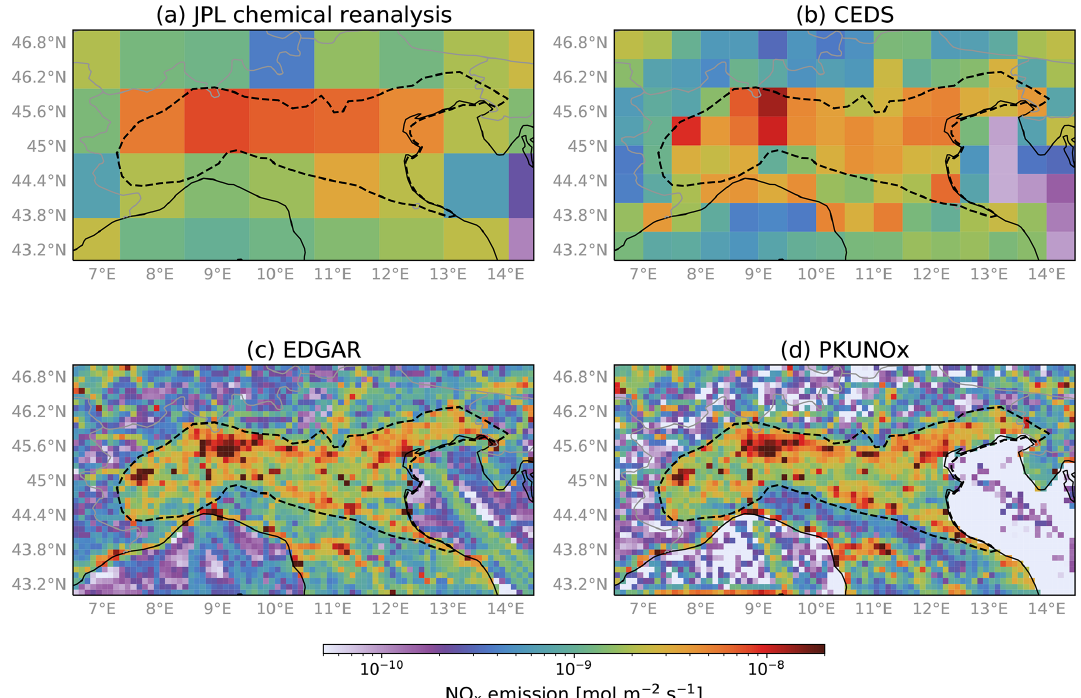
Figure 1. Spatial distribution of annual NO x emissions in 2005 near the Po Valley air basin (black dashed line) from (a) JPL chemical reanalysis, (b) CEDS, (c) EDGAR, and (d) PKUNOx.